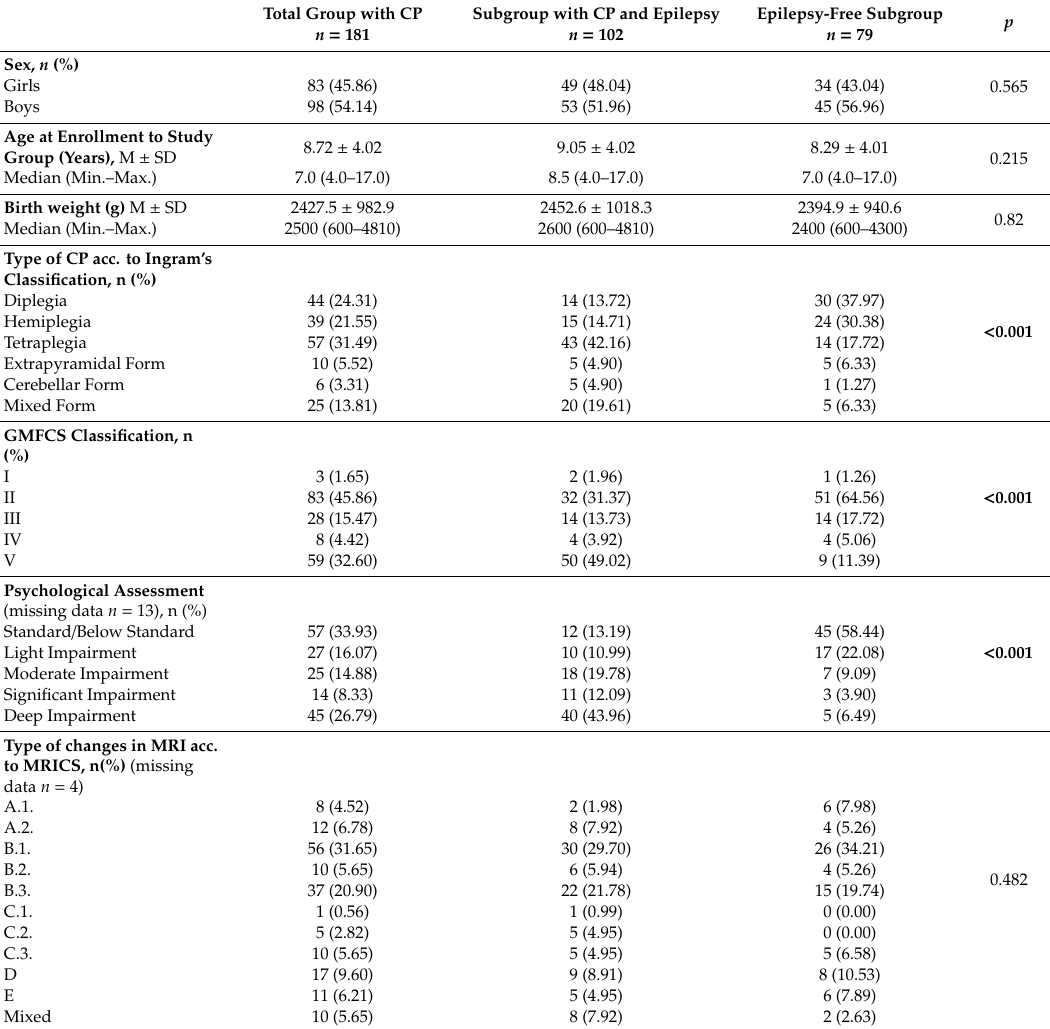
Table 1. Characteristics of the study group. Total Group with CP Subgroup with CP and Epilepsy Epilepsy-Free Subgroup p n = 181 n = 102 n =